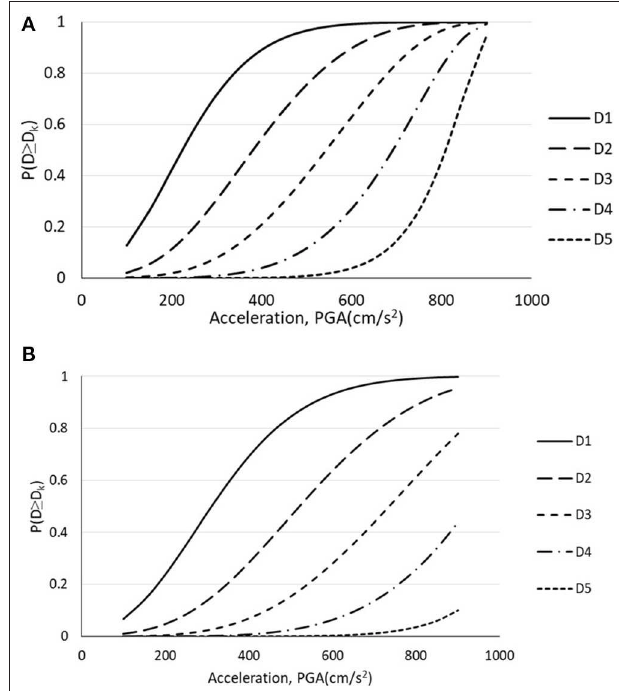
FIGURE 7 | Fragility curves as a function of peak ground acceleration for (A) URM and (B) CM buildings surveyed after the Sarpol-e-zahab earthquake